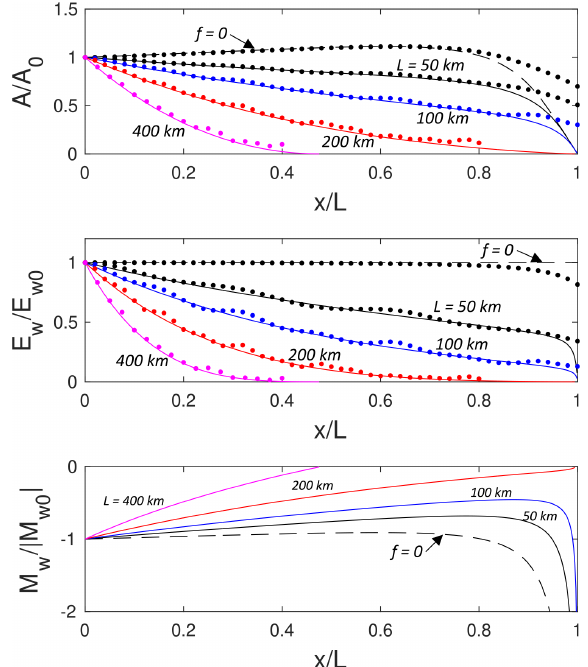
Figure 5. Adiabatic theory for wave propagation from deep to shallow in a two-layer system, with h 1 = 50m, h 20 = 450m, g (cid:48) = 0 . 005ms − 2 , f = 10 − 4 s − 1 , and A 0 = − 25m. A/A 0 , E w /E w0 , and M w / | M w0 | are shown as functions of x/L . The solid lines are for L = 50 (black), 100 (blue), 200 (red), and 400km (magenta). The dashed lines are for f = 0. The dots are from the solutions of Eq.